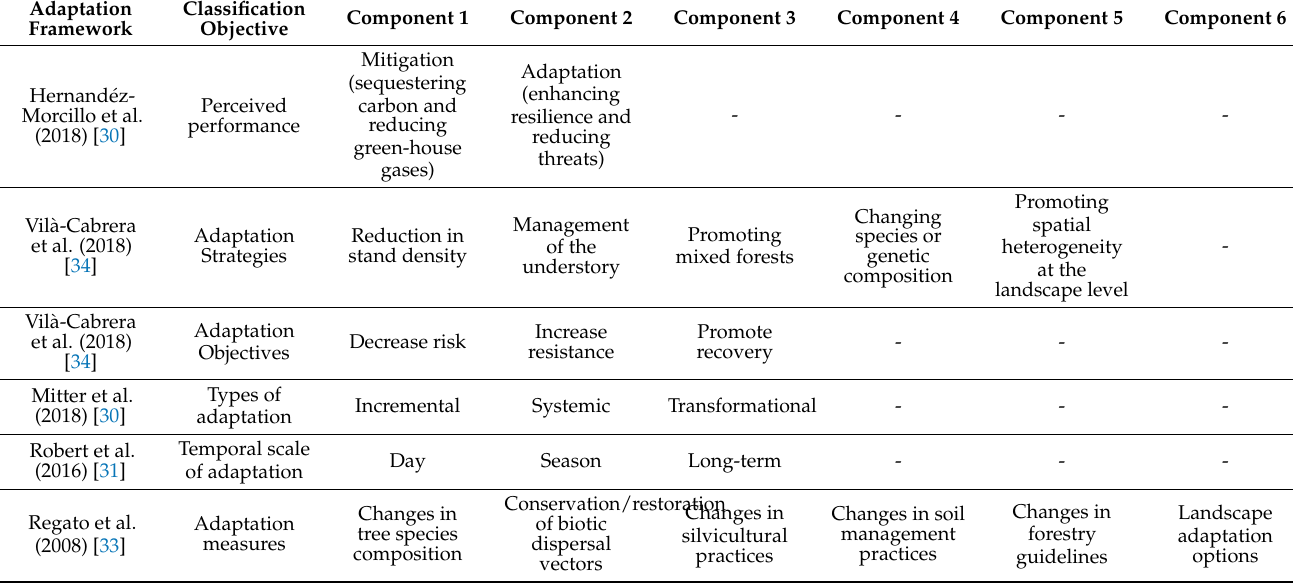
Table 1. Climate adaptation frameworks for agriculture and forestry. Each framework categorizes adaptation measures according to different classification objectives. The different components presented by the different frameworks, are shown in columns Component 1 to Component 6 and illustrate the complexity present in planning adaptation in this